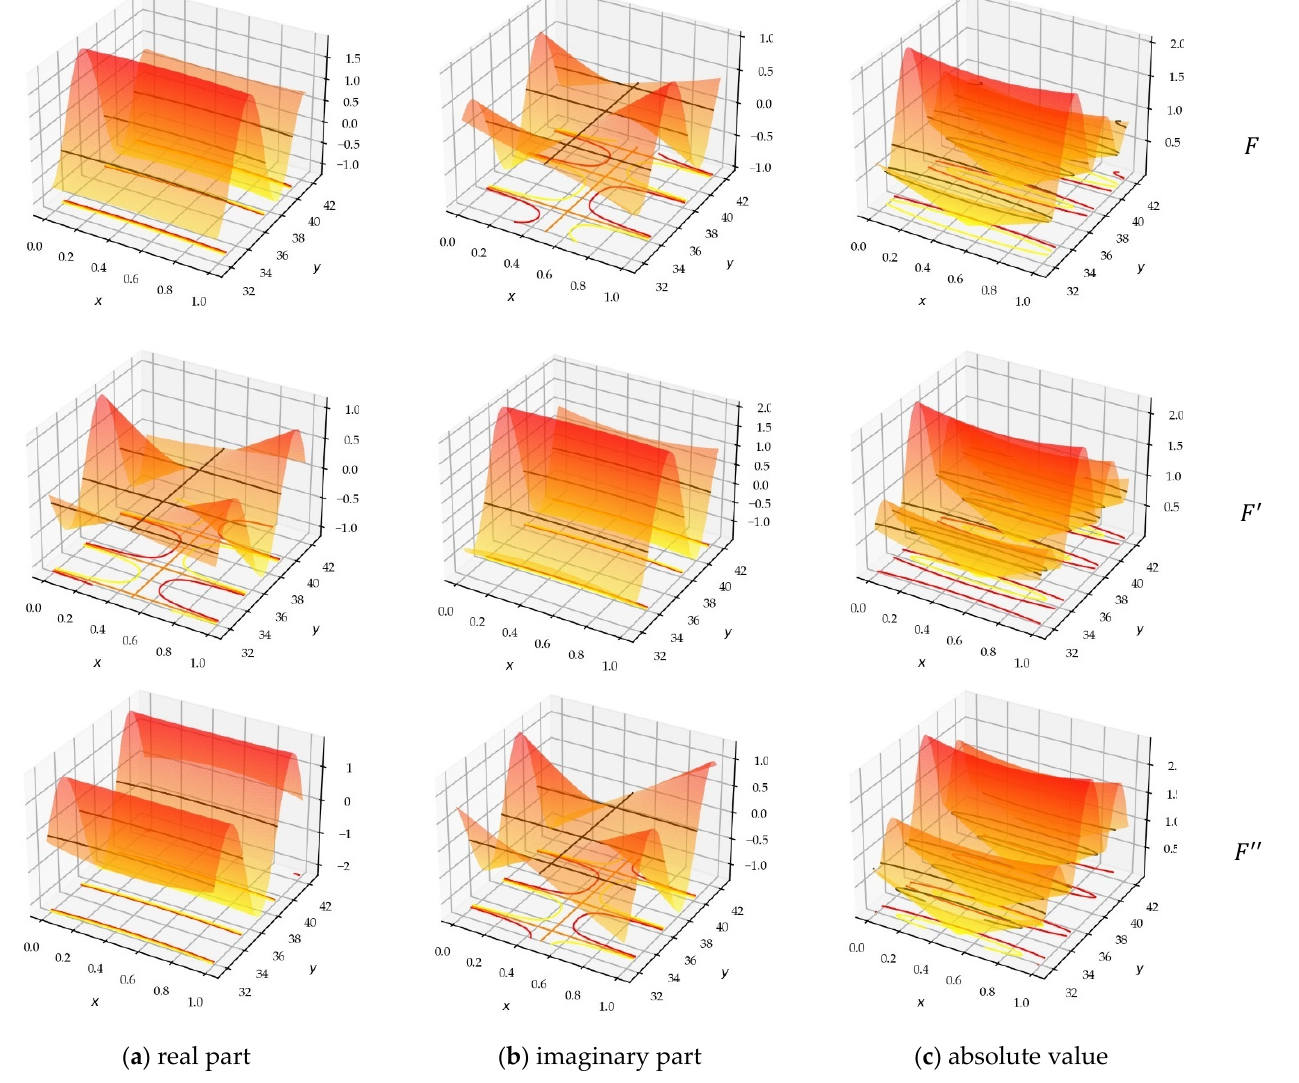
Figure 7. Plots of F , F (cid:48) , F (cid:48)(cid:48) : ( a ) real, ( b ) imaginary parts, and ( c ) modulus. The images of the different functions F ( n ) are similar, except that they exchange their real and imaginary aspects according to the parity of n